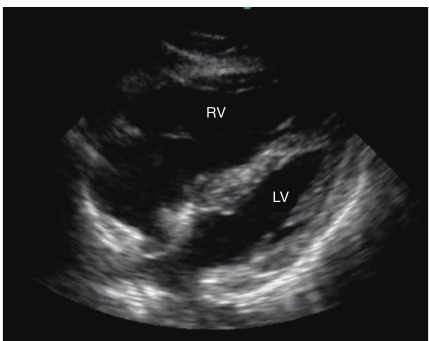
Figure 1: Cardiac ultrasound, subxiphoid view showing a dilated right ventricle (RV).